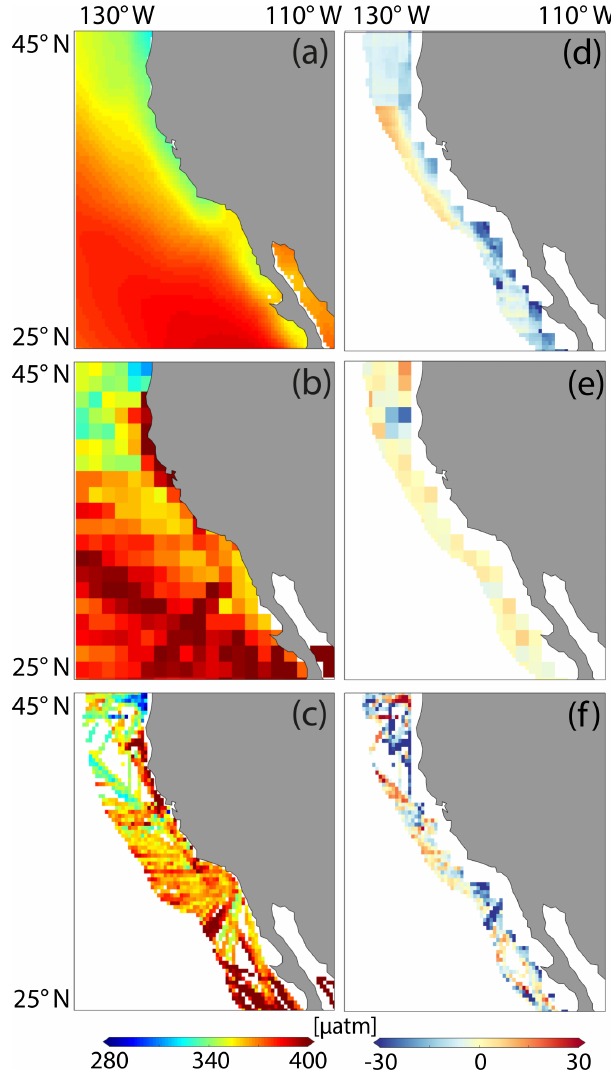
Figure 12. Mismatch analysis along the United States west coast for the 1998 through 2015 period. The climatological mean p CO 2 is reported for (a) the merged product, (b) all available SOCATv5 data for the open ocean, and (c) all coastal SOCATv5 data (as illustrated in Fig. 1 for the global ocean). The p CO 2 mismatch is illustrated in (d) as the difference between NN coast and NN open . Panel (e) reports the mismatch between the NN open and the SOCATv5 open-ocean dataset along the overlap area, while panel (f) reports the mismatch between the coastal product and the SOCATv5 coastal dataset along the overlap